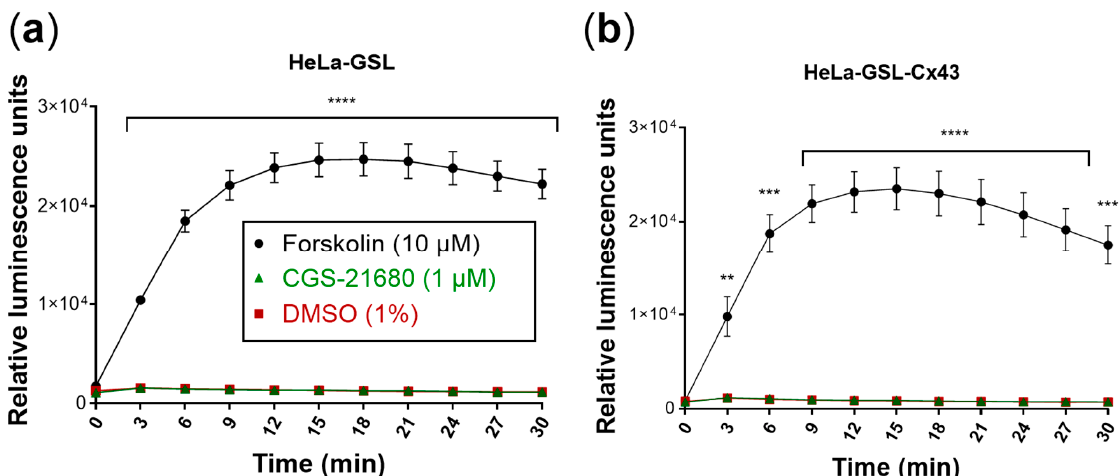
Figure 5. Evaluation of the biosensor cells. Forskolin (10 µ M) was used as a positive control and DMSO (1%) as a negative control. Means ± SEM of three individual experiments performed in duplicates are given. ( a ) Biosensor cells produced luminescence only in response to forskolin (10 µ M). Luminescence response to CGS-21680 (1 µ M) was not different from control (DMSO). ( b ) Cx43 transfection of biosensor (HeLa-GSL) cells did not affect luminescence responses. Statistical significance calculated with repeated measures 2-way ANOVA and Dunnet’s multiple comparisons test comparing treatments to control (DMSO, 1%). ** p < 0.01, *** p < 0.001, **** p < 0.0001.